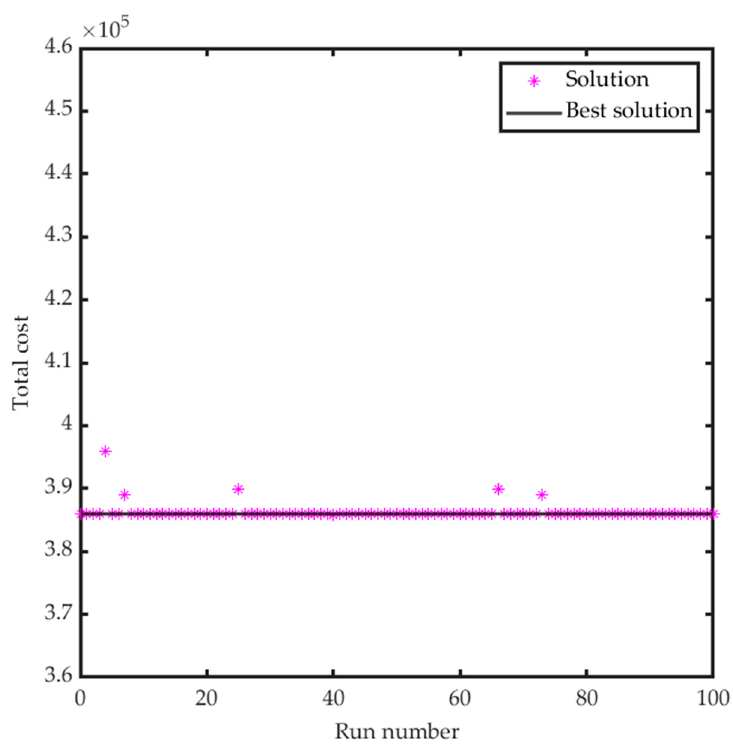
Energies 2022 , 15 , x FOR PEER REVIEW